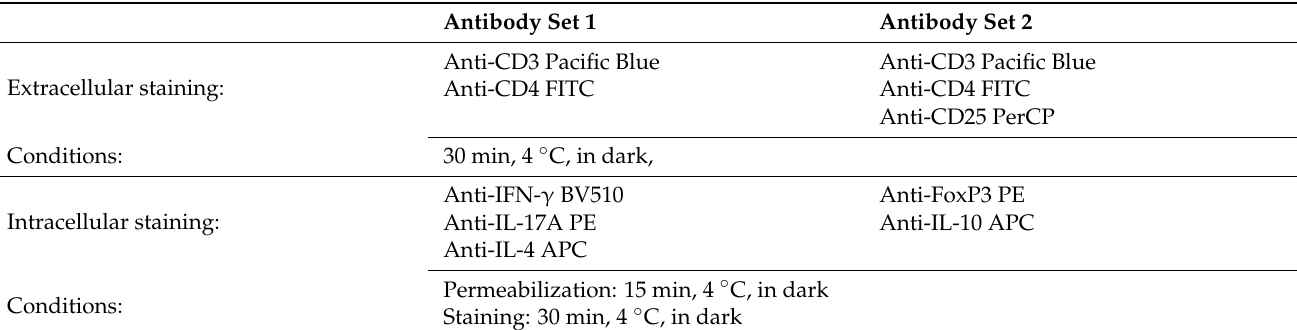
Table 1. Antibodies used for flow cytometry staining. Antibody Set